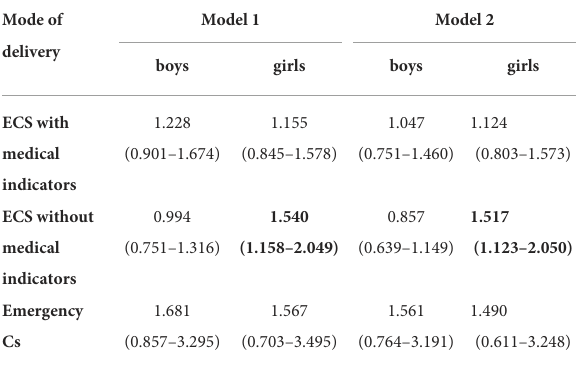
TABLE 4 Association between ECS and children’s EAR in boys and girls [OR